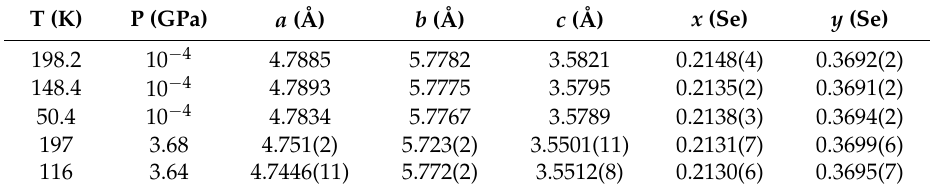
Table 3. Unit-cell parameters and atomic fractional coordinates at low temperature and both ambient pressure and high pressure. For ambient pressure, weighed averages of three crystals are reported.